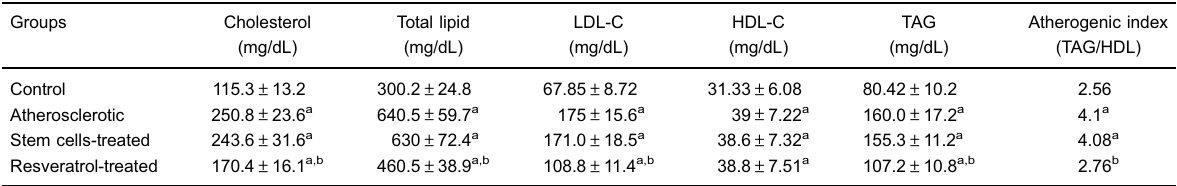
Table 2. Total lipids, total acyl glycerol (TAG), low-density lipoprotein cholesterol (LDL-C), and high-density lipoprotein cholesterol (HDL-C) in of rats experimentally induced with atherosclerosis and treated with stem cells or